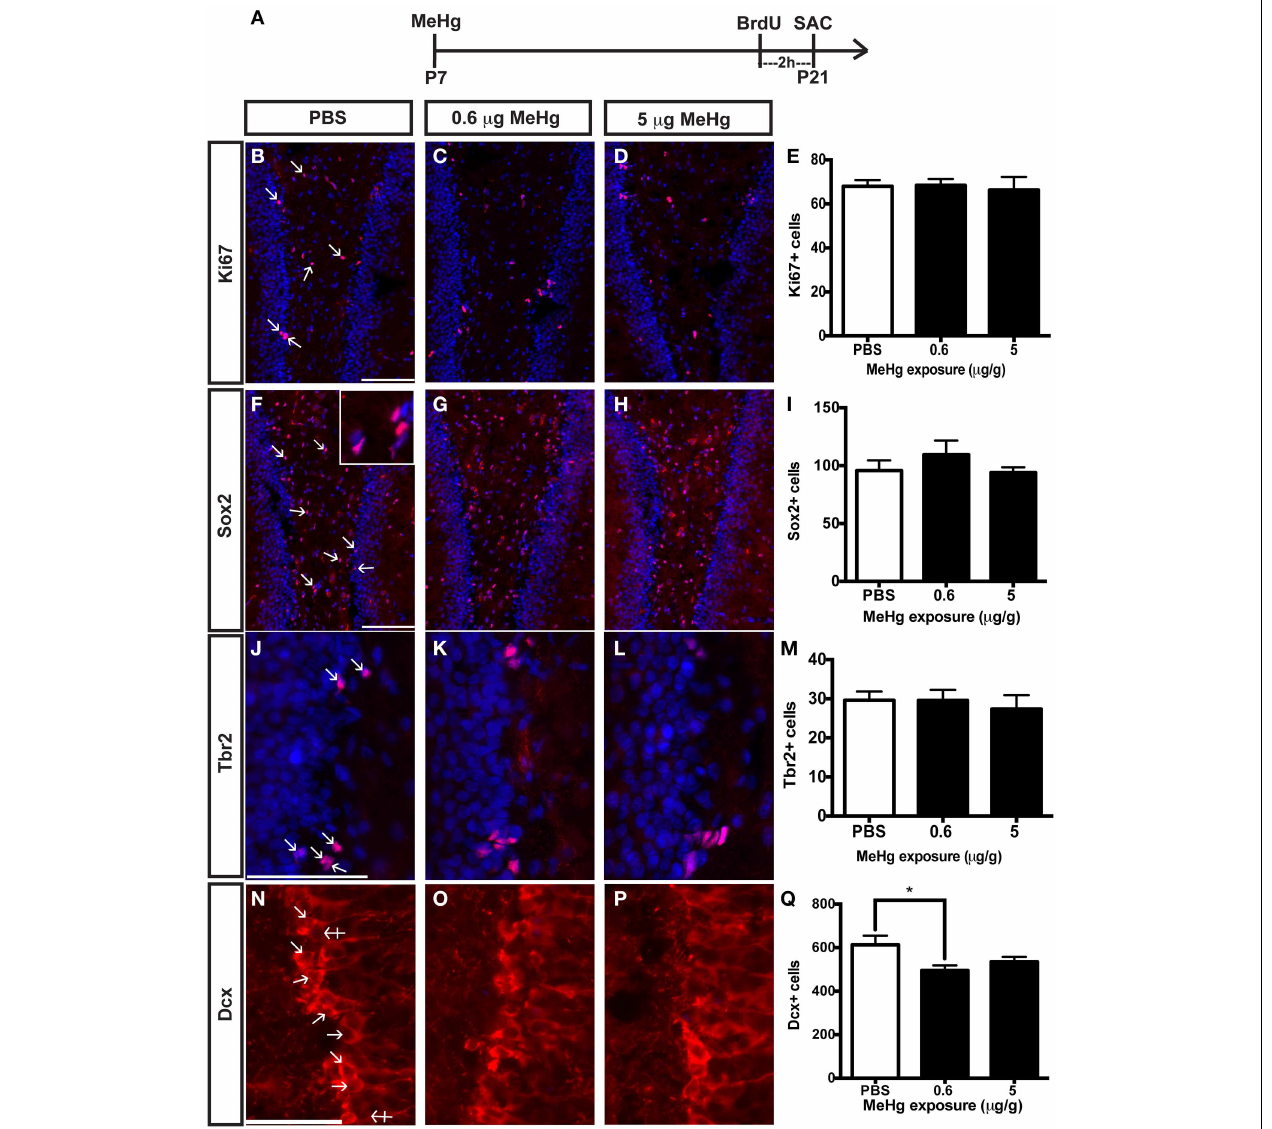
FIGURE 1 | Early (P7) MeHg exposure leads to an immature neuron deficit in the adolescent (P21) hippocampus. (A) Experimental timeline. Five coronal sections of the hippocampus per brain were counted. (B–D) Ki67 (red) staining in the hilus of the dentate gyrus (DG). Arrows indicate positive cells. Nuclei are labeled with DAPI (blue). (E) Quantification of the average number of Ki67 + cells per section per animal in the hilus. Animals: n = 6 –7 per group. Each bar represents mean ± SEM. Scale bars: 100 µ m. (F–H) Sox2 (red) staining in the hilus of the DG. (I) Quantification of the